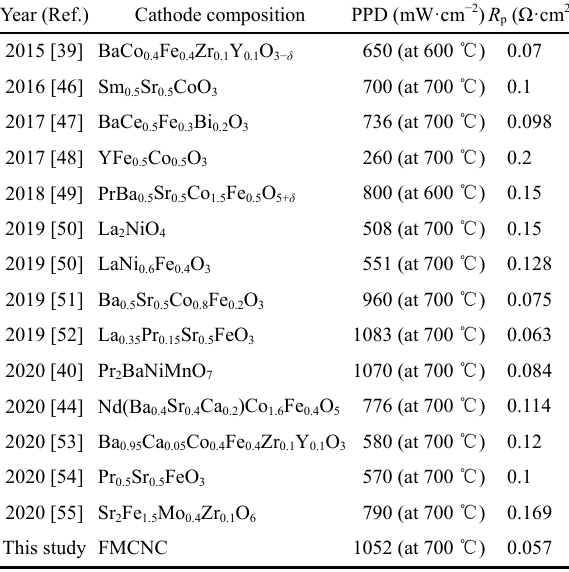
Table 2 Comparison of PPD and the corresponding R p for the H-SOFC using FMCNC cathode with those recently reported in the literature. Testing temperatures are indicated Year